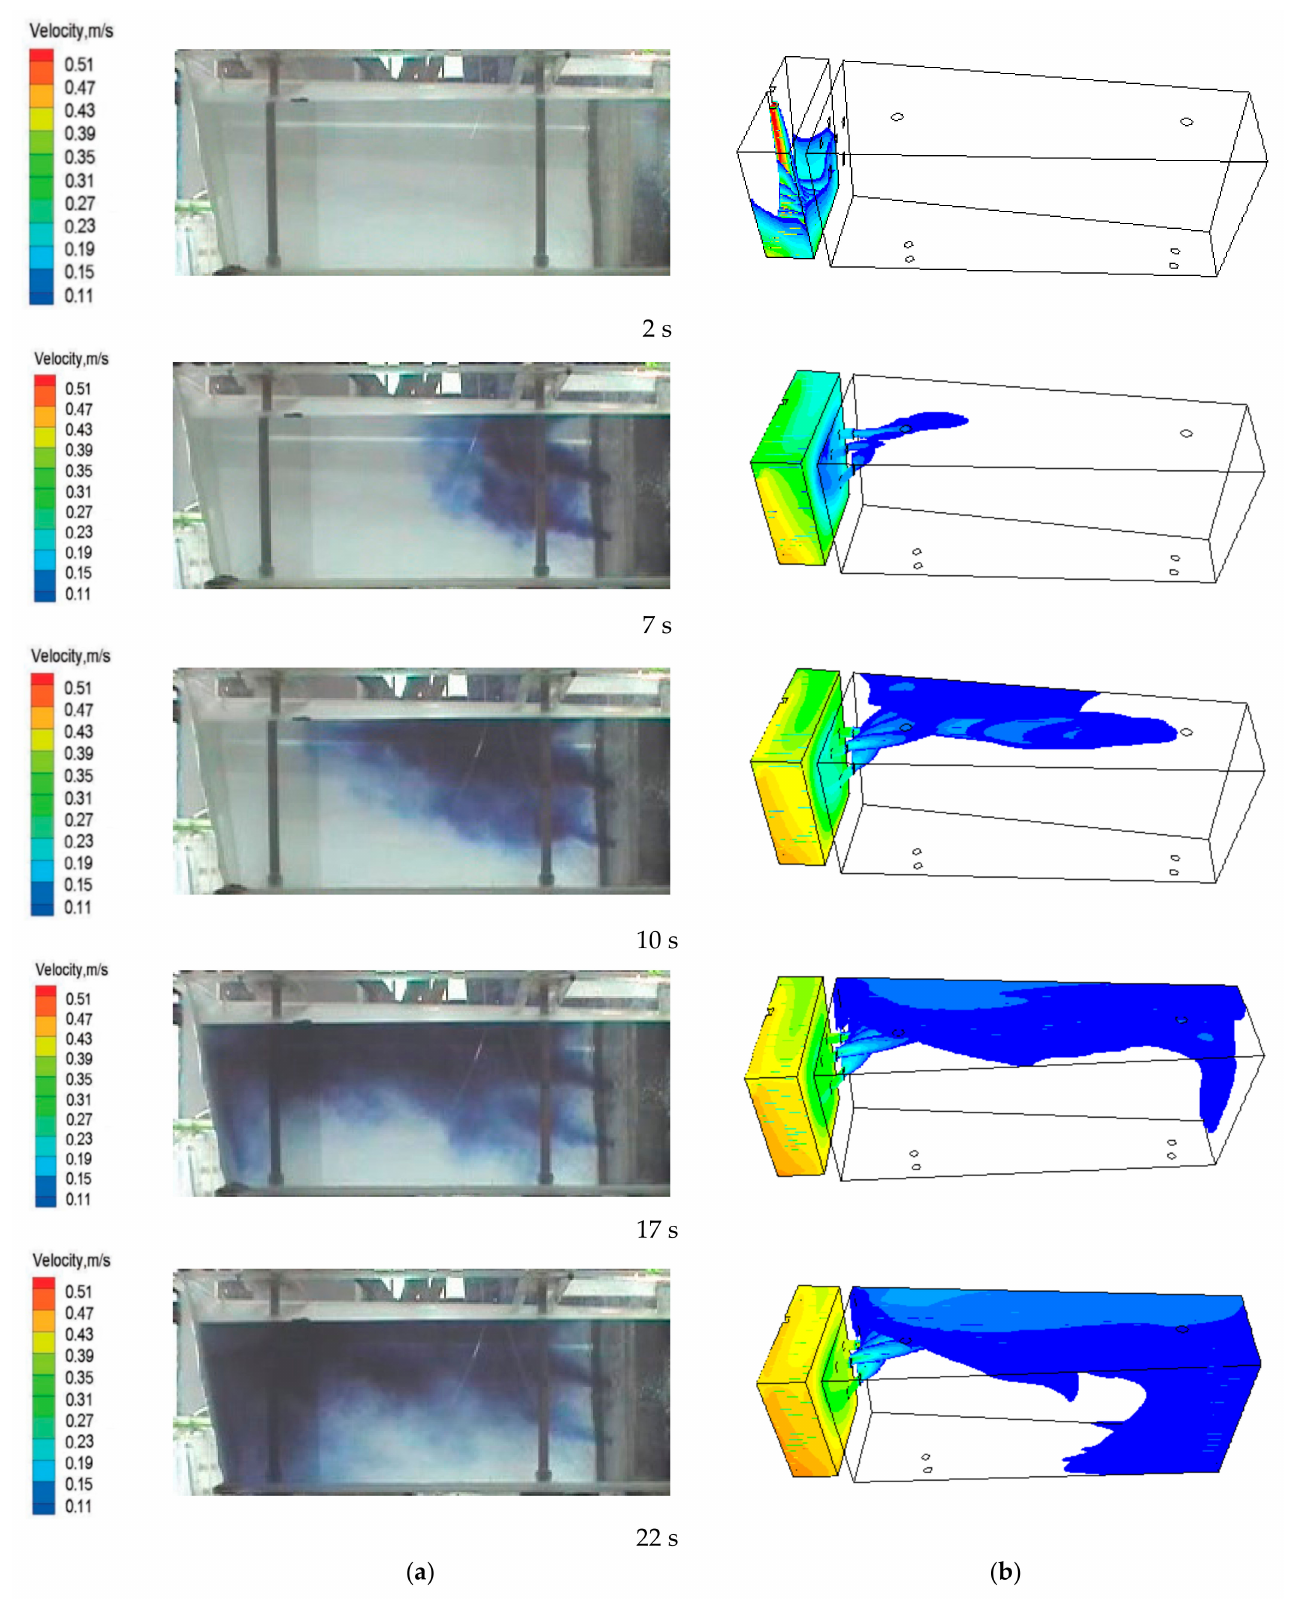
Figure 3. Comparison of concentration field between physical simulation and mathematical simula- tion. ( a ) physical modeling results; ( b ) mathematical modeling